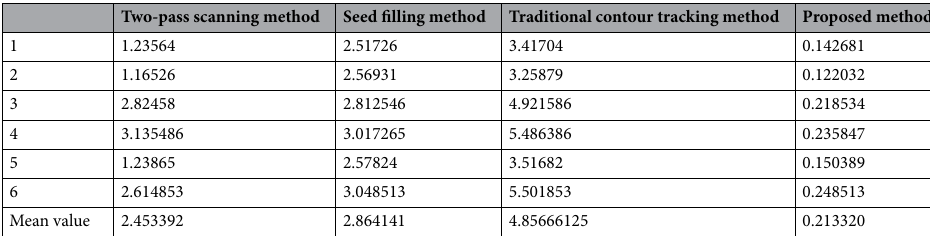
Table 1. Performance comparison of different algorithms for different images (unit: